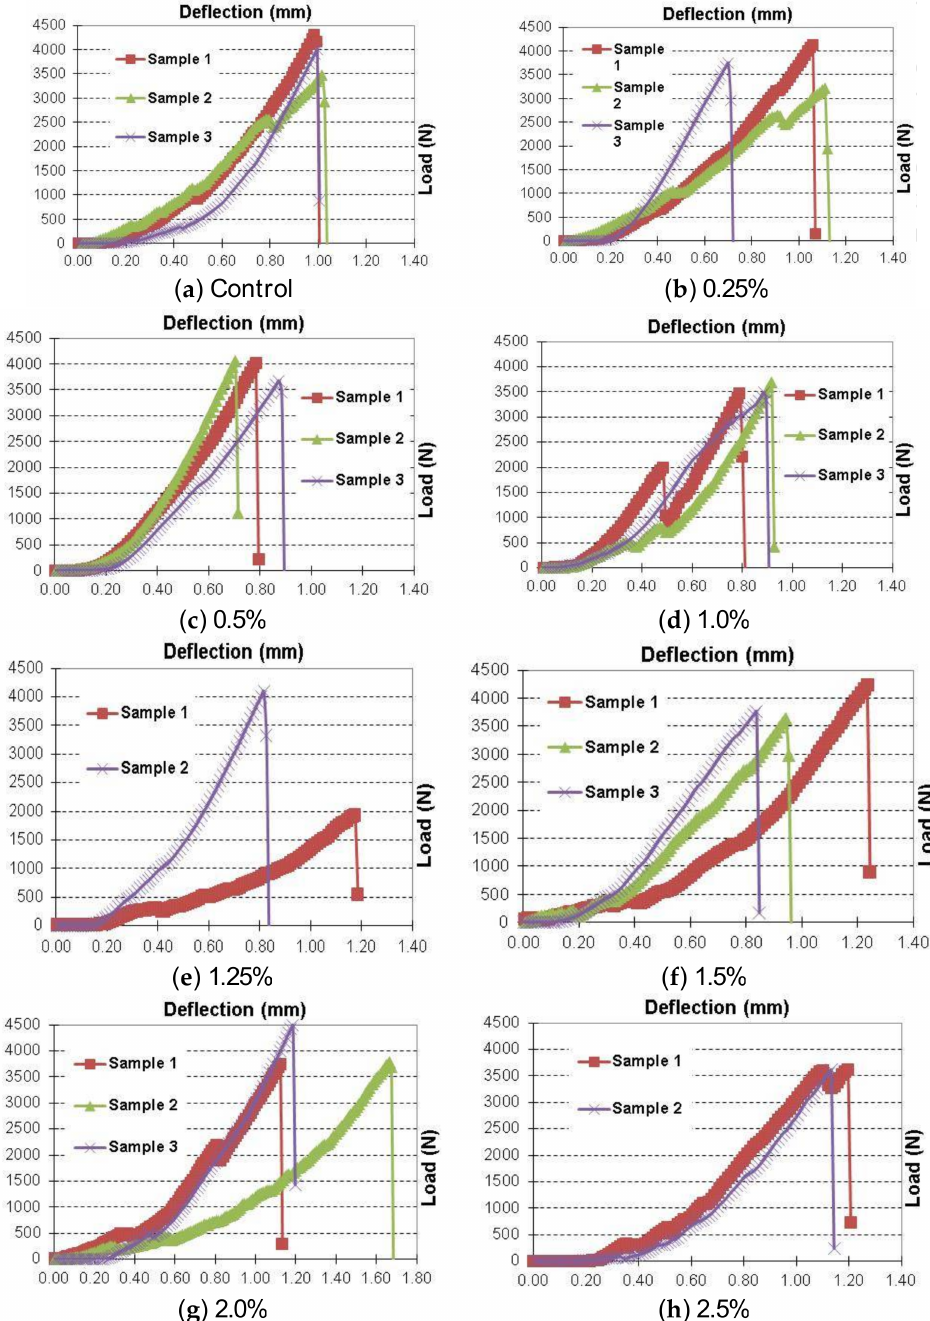
Figure 13. Load-deflection relationships due to thermal fatigue